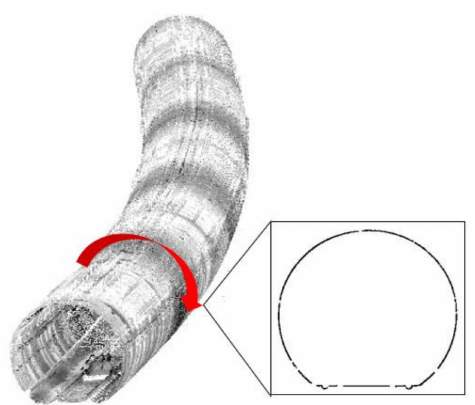
Figure 8. Cross-section